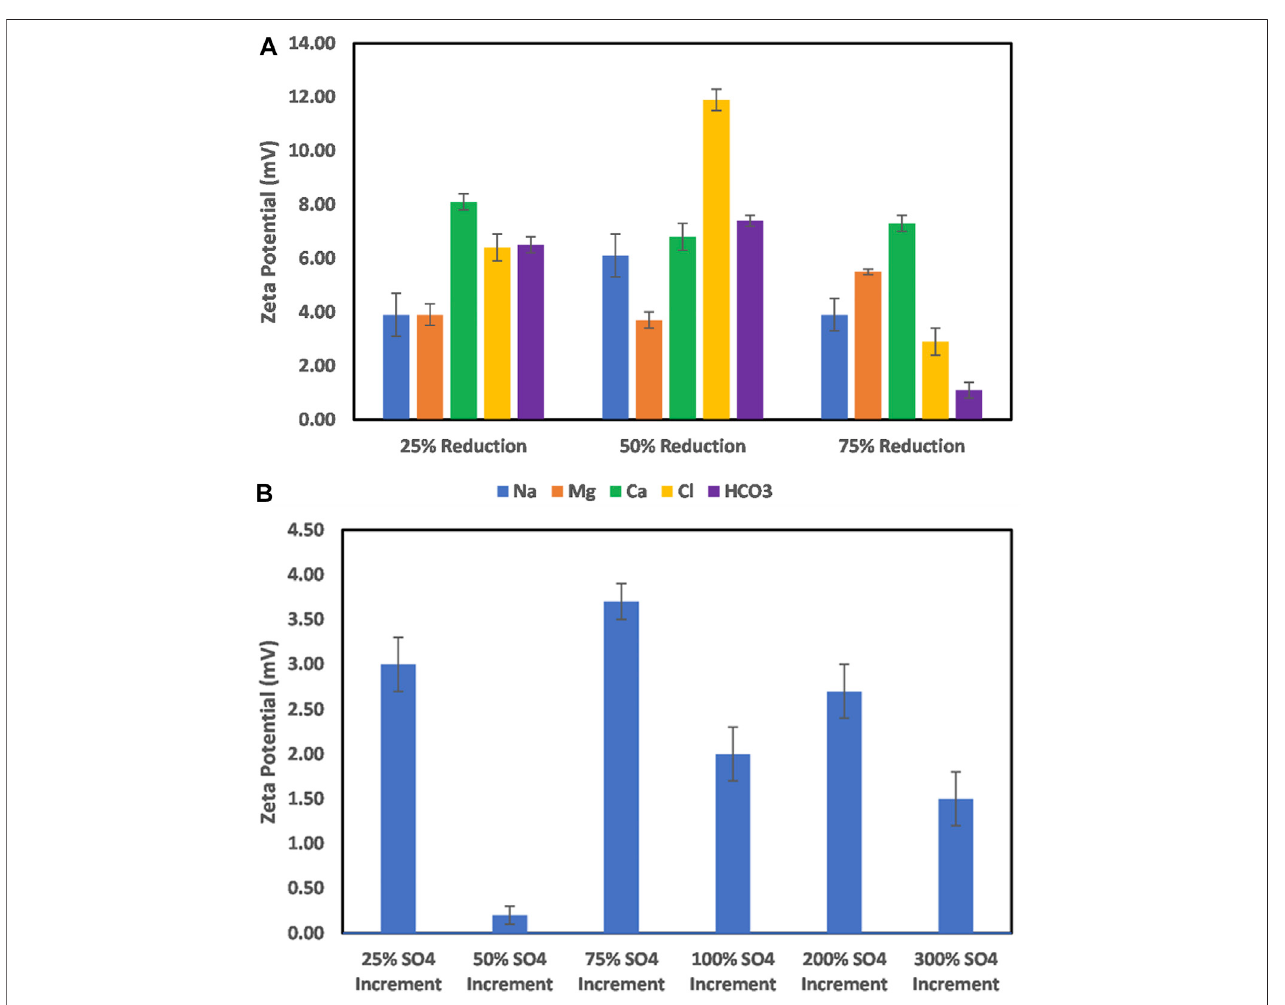
FIGURE 8 | (A) Effect of Na, Mg, and Ca, and HCO 3 ion concentration reduction on barite mineral surface charge. (B) Effect of increase in the sulfate ion concentration on barite mineral surface charge.